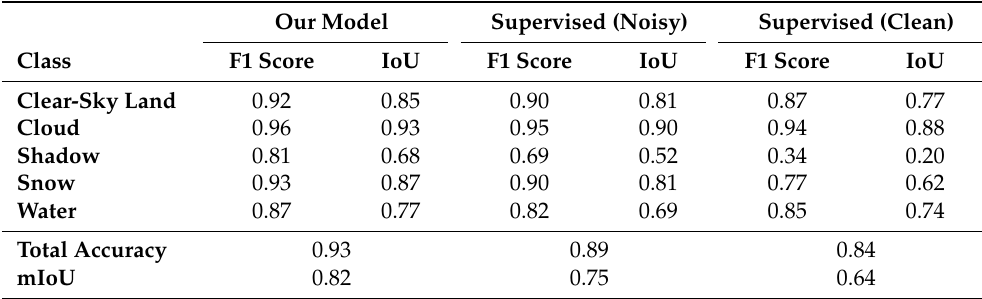
Figure 6. Comparison of test image results from different stages of the self-training framework and the results from the models trained using supervised training, from Tile 04WDV in Alaska, USA, captured on 27 October 2020. Table 11. Comparison of F1 score and IoU with the models trained using the supervised training approach. The model in column Supervised (noisy) was trained on the entire training dataset using the Fmask labels and the model in column (clean) was trained on the validation dataset using the manually annotated